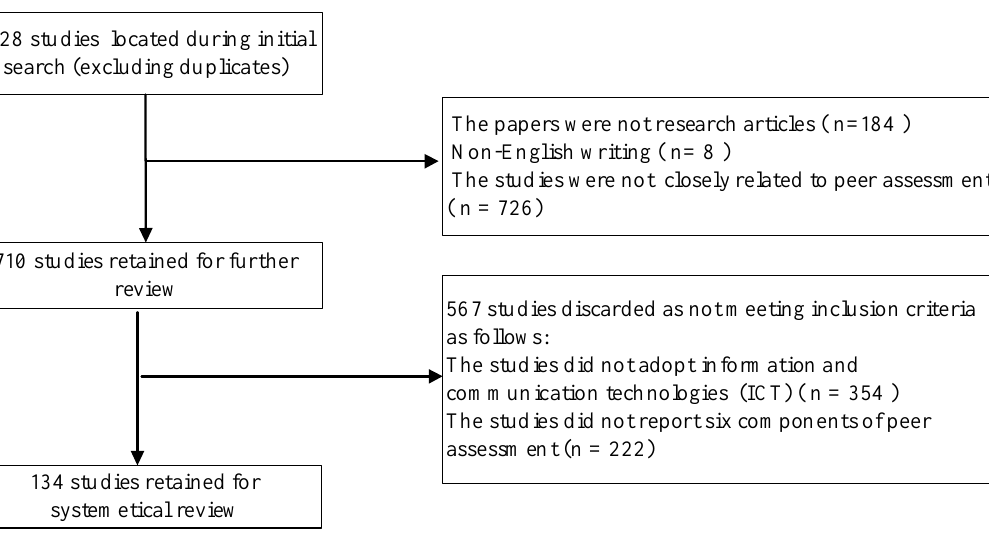
Figure 1 . Papers selection